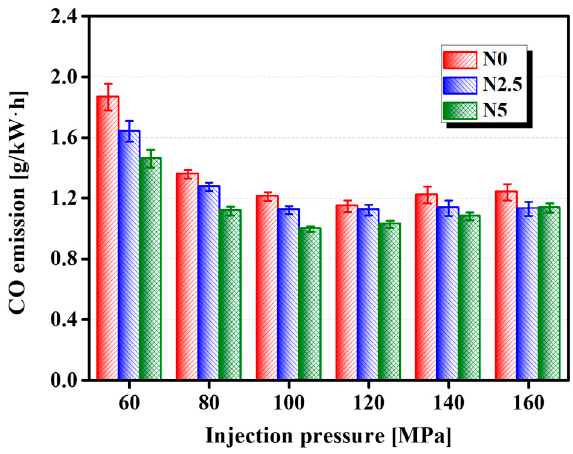
Figure 9. CO emissions of different injection pressures for n -octanol/diesel blend fuels.